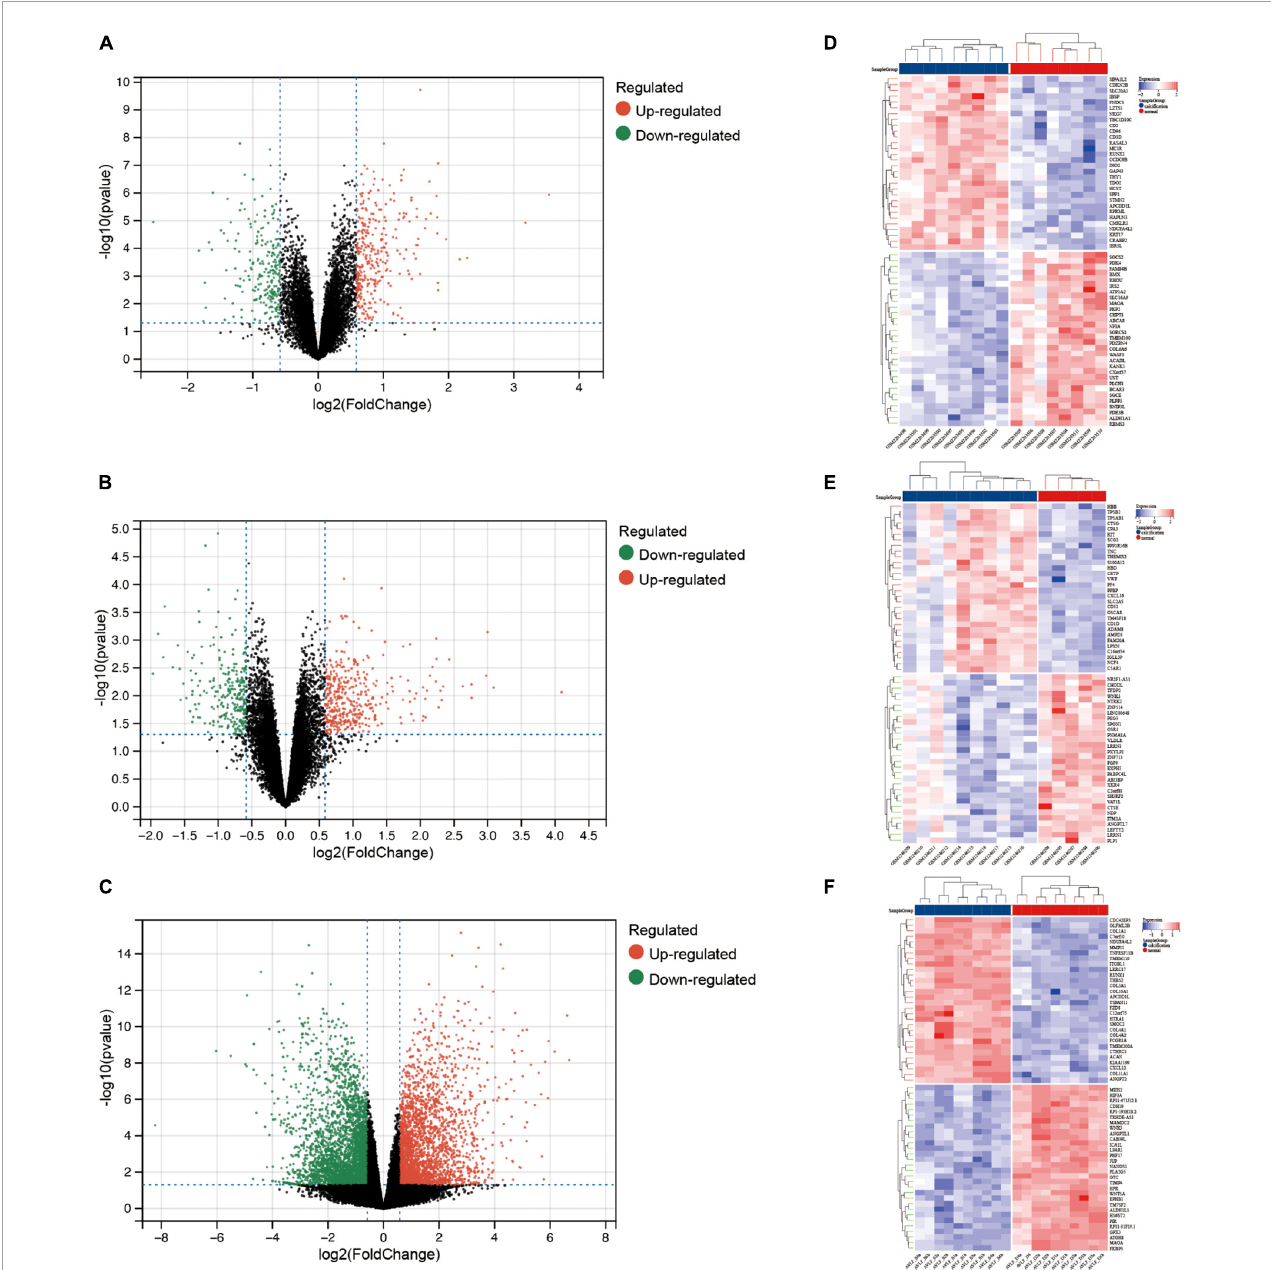
FIGURE1 Differentially expressed genes between calcified and normal aortic valve samples. Volcano plots for differential gene expression data from: (A,D) GSE83453, (B,E) GSE51472, (C,F) GSE153555. In the volcano plots and heatmap, the red sections show upregulated genes (log2FC ≥ 0.5 and adjusted p -value < 0.05), whereas the green/blue sections represent downregulated genes; black dots represent no significant difference.